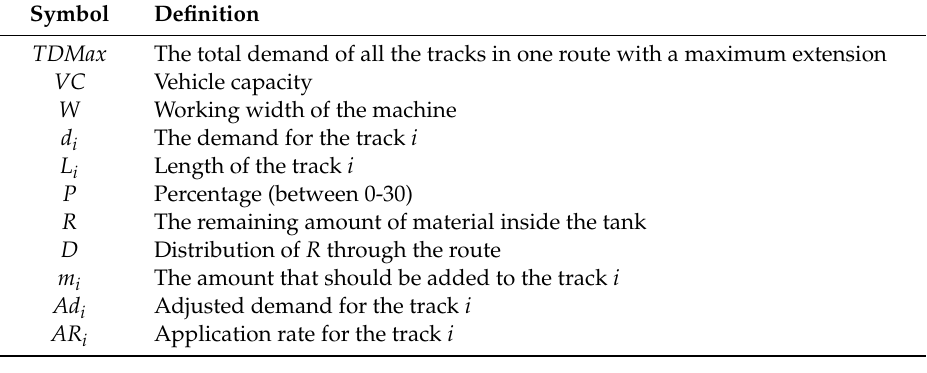
Figure 5. Calculation of application rates. Table 4. Definition of the symbols used in the calculation of the application rates.